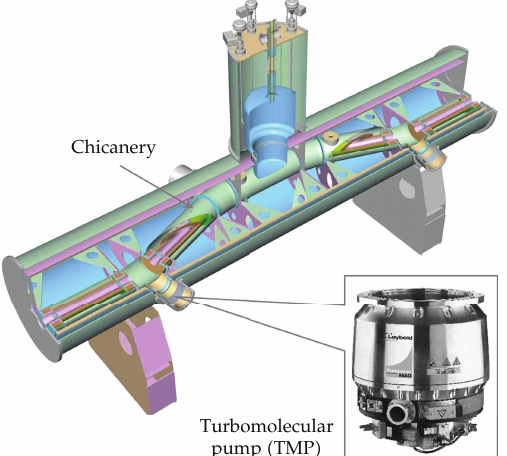
Figure 17: Schematic view of the 6.96 m long DPS2-F cryostat. The beam tube guiding the 𝛽 -decay electrons features a chicane to avoid themolecularbeamingeffect.AtthefourpumpportslargeTMPsare installed for differential pumping. The beam tube instrumentation includes FT-ICR units and through-shaped electrodes for ion diagnostics and